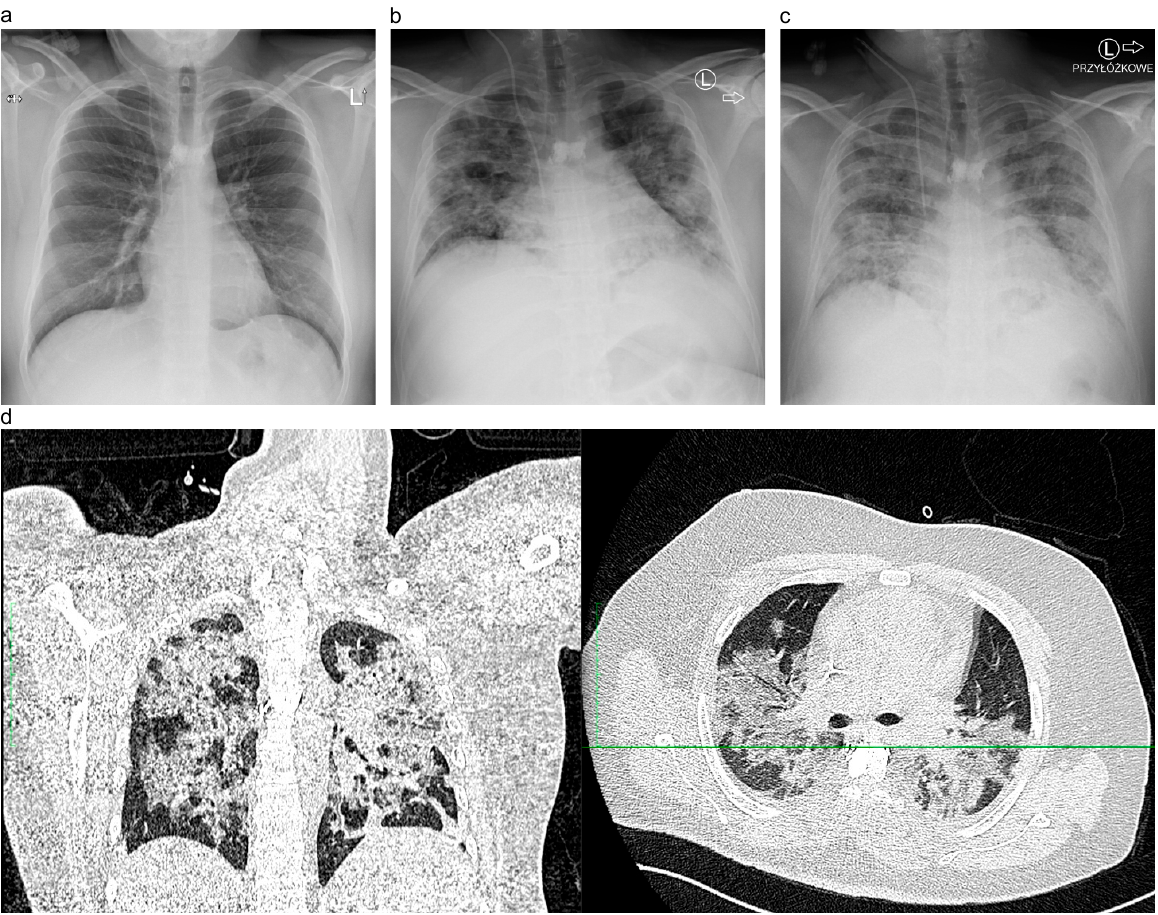
Figure 1. Comparison between patient’s chest X-ray imaging in different time points: ( a ) initial imaging (day -8); ( b ) clinical deterioration (day +8); ( c ) respiratory failure (day +10). Chest CT scans performed on day +9: ( d ) frontal + transverse plane. L – left site. Przy ł ó ż kowe – bedside X-ray.